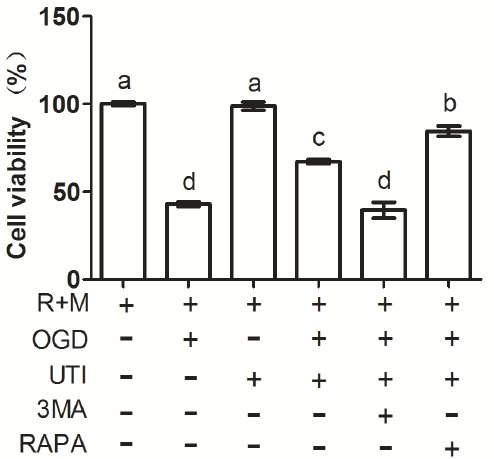
Figure 2: Cell autophagy influenced the regulation of UTI on the activity of renal tubular epithelial cells. R: Renal tubular epithelial cells; M: Macrophage; OGD: Oxygen glucose deprivation; UTI: Ulinastatin.; 3MA: 3-Methyladenine; RAPA: Rapamycin. Bars with different letters are significantly different (p <